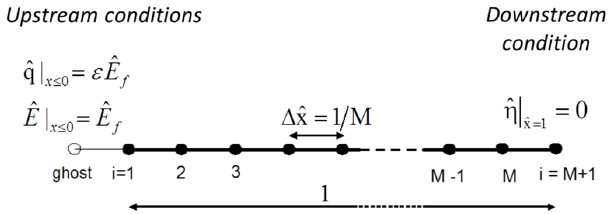
Figure 1. Discretization of the